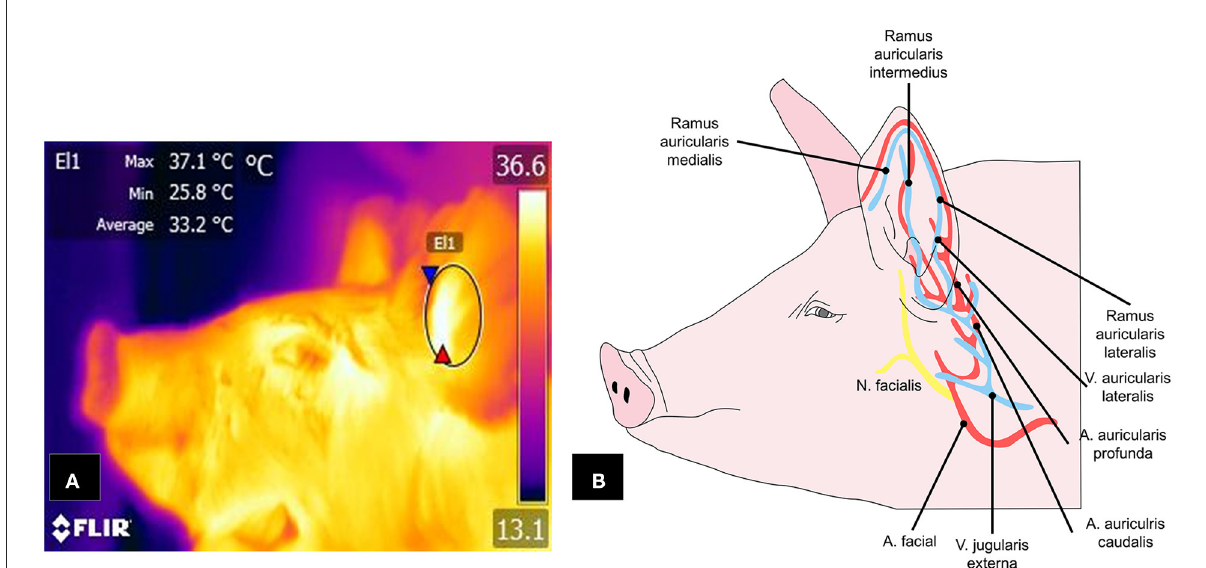
FIGURE6 Auricular window in pigs. (A) The window is delimited by an ellipse (E1) that includes the central cartilage. (B) Circulation from the facial artery and external jugular vein, with their respective branches, spreads into the ramus auricularis medialis , intermedius , and lateralis , which are responsible for transporting blood to the ear pavilion and that respond to activation of the ANS.